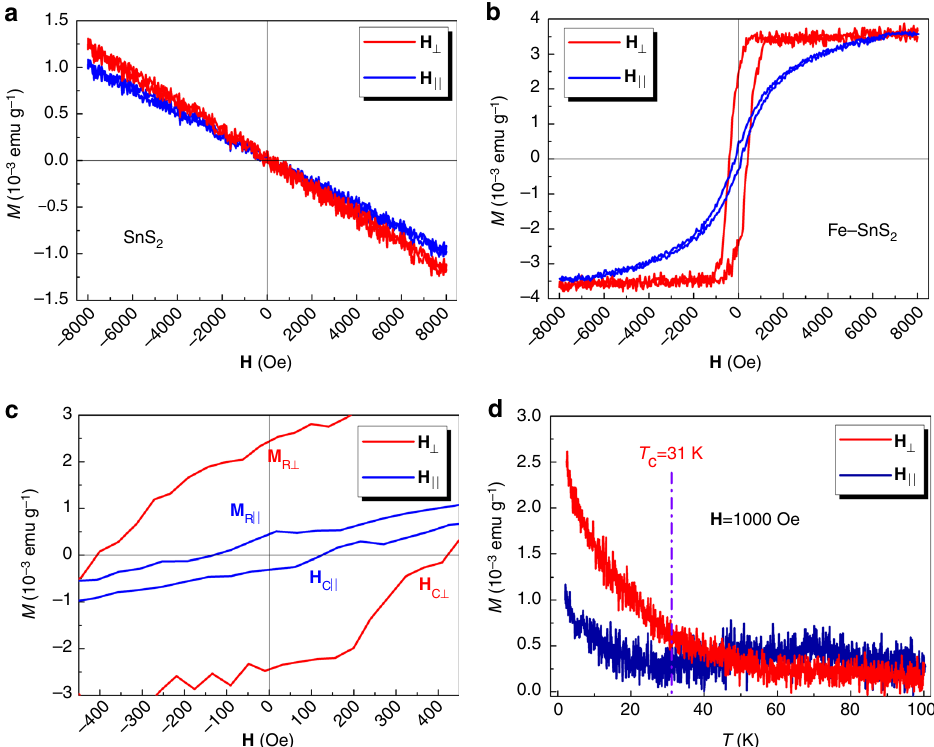
Fig. 3 Magnetization data for SnS 2 and Fe 0.021 Sn 0.979 S 2 . a , b Magnetic hysteresis loops for SnS 2 and Fe 0.021 Sn 0.979 S 2 at 2 K using VSM, respectively. c Expanded view of the loop of